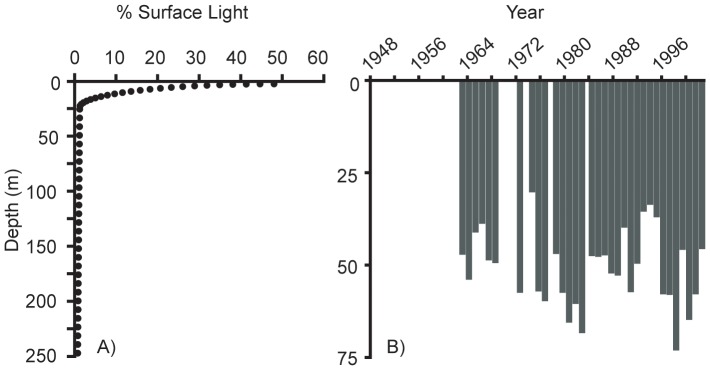
Average light extinction curve and photic zone in Lake Baikal.Light extinction with depth is shown in panel A, with the depth of the average photic zone (0.1% surface light) for each year in panel B.